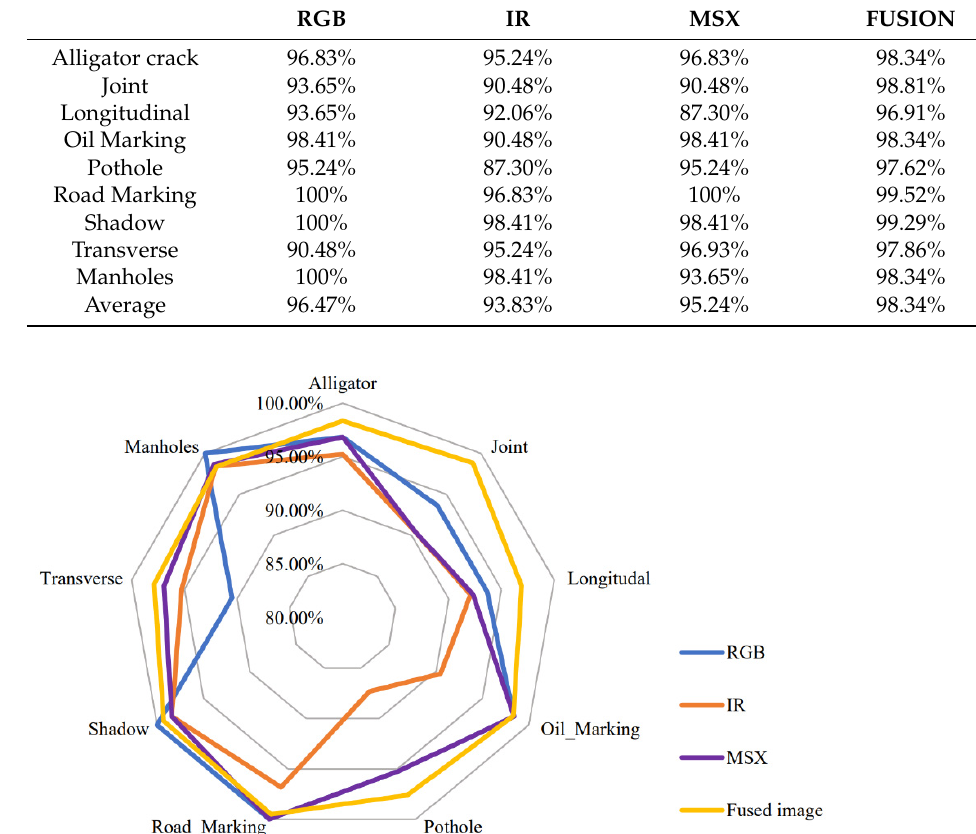
Figure 12. Comparison of performance for each class with different input data.